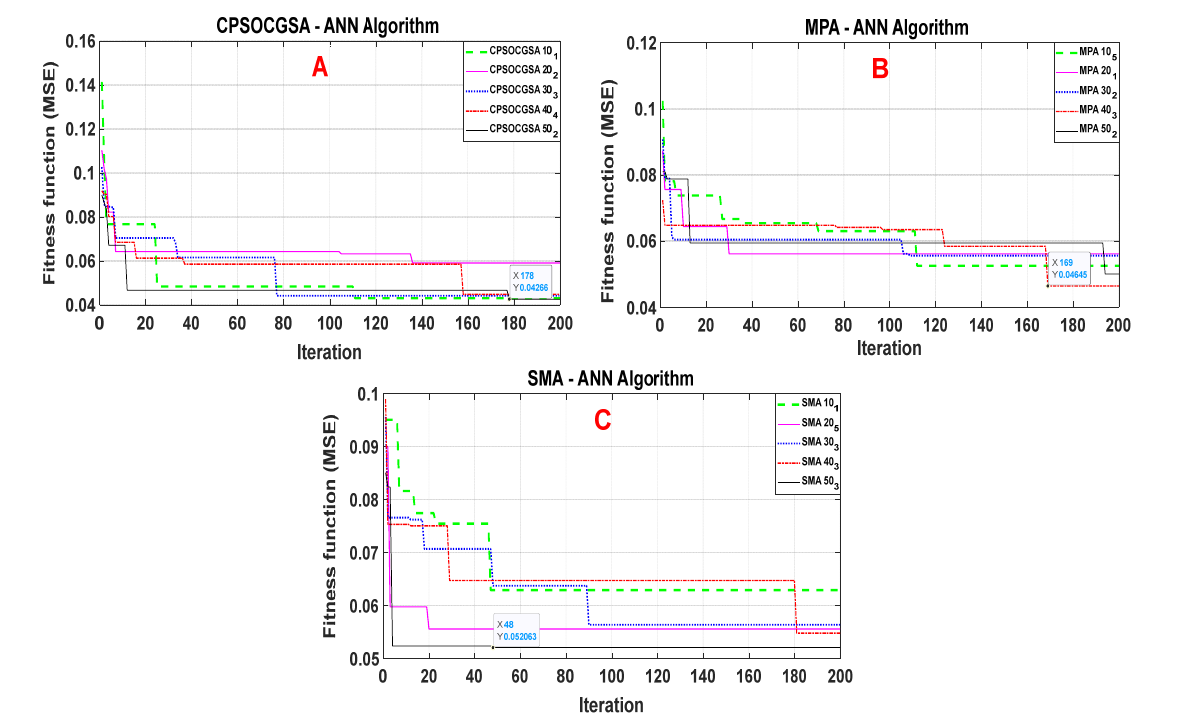
Figure 6. Performance of the CPSOCGSA-ANN, MPA-ANN, and SMA-ANN algorithms for SPI 1.